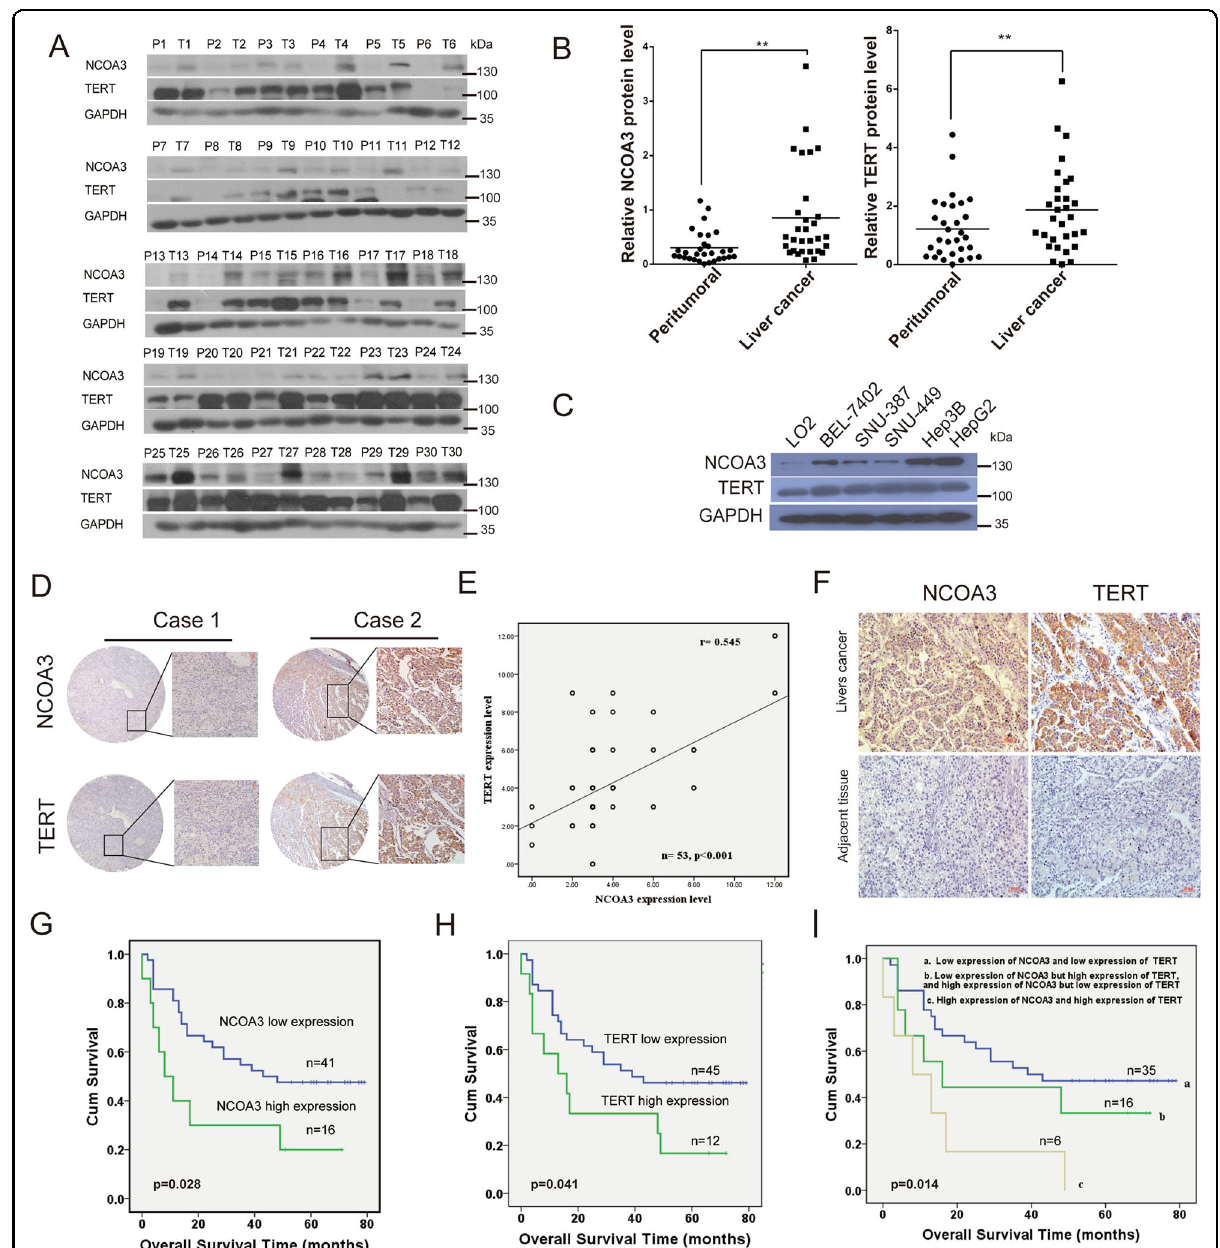
Fig. 6 The expression of NCOA3 and TERT in HCC tissues and were associated with poor clinical outcomes in HCC patients. A Expression of NCOA3 and TERT in the peritumor (P) and tumor (T) tissues was detected by western blot in 30 human HCC tissues. B Quanti fi cation of NCOA3 and TERT protein expression in ( A ), GAPDH as an internal control, data were shown as means ± SD, ** p < 0.01, n = 30, Student ’ s t test. C Protein level of NCOA3 and TERT in immortalized LO2 and HCC (BEL-7402, SNU-387, SNU-449, Hep3B, and HepG) cells. D Representative images of IHC staining of NCOA3 and TERT in HCC tissues using a tissue microarray. E The expression of NCOA3 and TERT were positively correlated in HCC tissue microarray. The statistical test indicated a signi fi cant ( p < 0.001) positive correlation, by a two-tailed Pearson correlation test, n = 53, r = 0.545. F Representative images of IHC staining of NCOA3 and TERT in HCC and adjacent normal tissues. G – I Prognosis of HCC patients with high or low expression of NCOA3 ( G ), TERT ( H ), and NCOA3 + TERT ( I ) was shown by Kaplan – Meier overall survival curves. Fifty-seven HCC tissues including 45 from the tissue microarray (Fig. 6E, 45/53) and 12 from HCC patients in Fig. 6A, (12/30) were used to analyze clinical outcomes in Fig. 6G – I. NOCA3 low expression ( n = 41), blue line, NOCA3 high expression ( n = 16), green line, p = 0.028 in Fig. 6G; TERT low expression ( n = 45) blue line, NOCA3 high expression ( n = 12), green line, p = 0.041 in Fig. 6H; NOCA3/TERT low expression ( n = 35), blue line, NOCA3/TERT high expression ( n = 6), copper-colored line, NOCA3 low/TERT high expression and NOCA3 high/TERT low expression ( n = 16), green line, p = 0.014; Kaplan – Meier test.